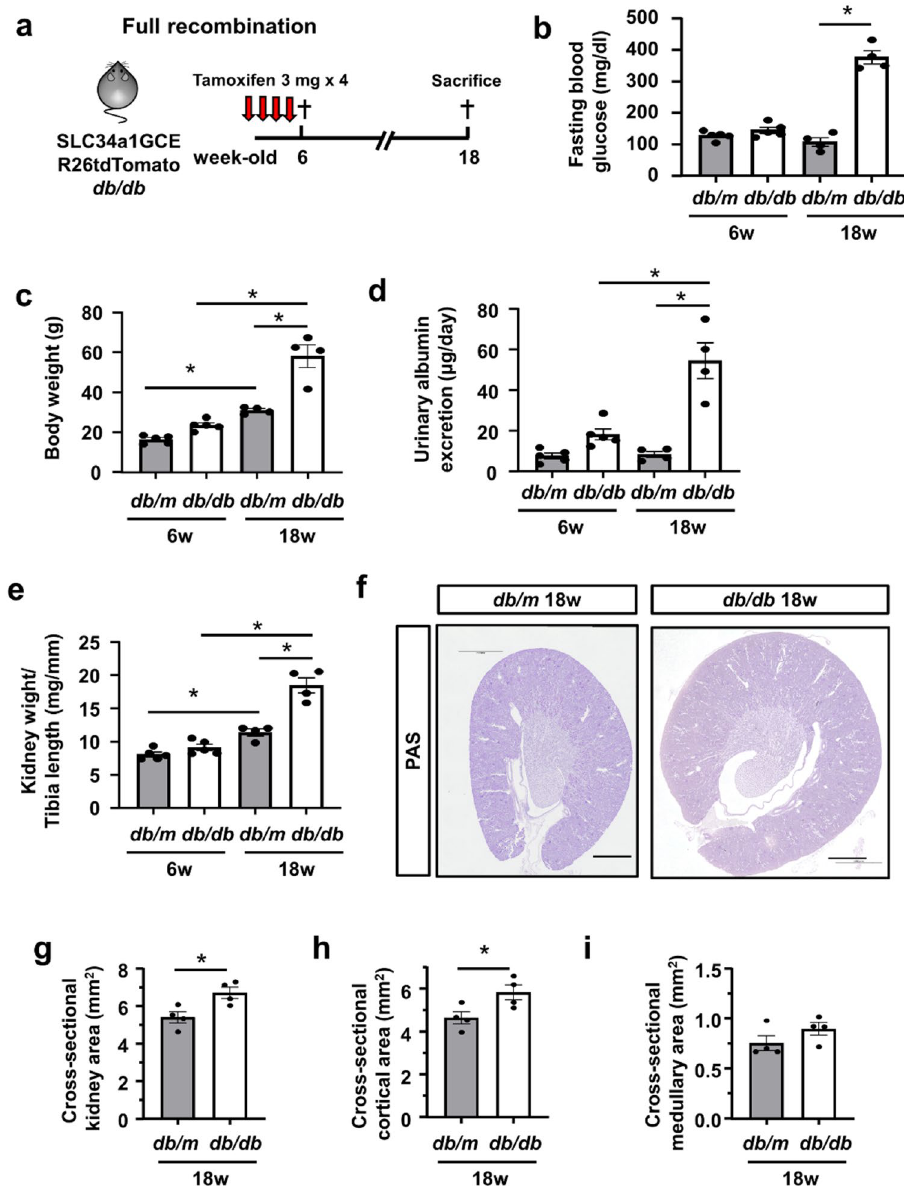
Figure 1. Kidney growth in db/db mice. ( a ) Experimental protocol. High-dose tamoxifen was injected 5 times into 6-week-old trigenic SLC34a1GFPCreERT2 (SLC34a1GCE), Rosa26-tdTomato (R26tdTomato), and db/db mice. Trigenic mice with SLC34a1GCE, R26tdTomato, and db/m were used as the non-diabetic control. ( b , c ) Fasting blood glucose and body weight were higher in db/db mice than in db/m mice at 18 weeks. ( d ) Urinary albumin excretion was higher in db/db mice than in db/m mice at 18 weeks. ( e ) Kidney weight/tibia length significantly increased in db/db mice at 18 weeks. ( f ) Representative PAS staining of kidney sections. ( g – i ) The cross-sectional kidney area ( g ) was larger in db/db mice at 18 weeks, especially in the cortex ( h ), but not in the medulla ( i ). N = 4–5 mice in each group. For all groups, data are means ± SEM, *p < 0.05, Bar = 1 mm in ( f